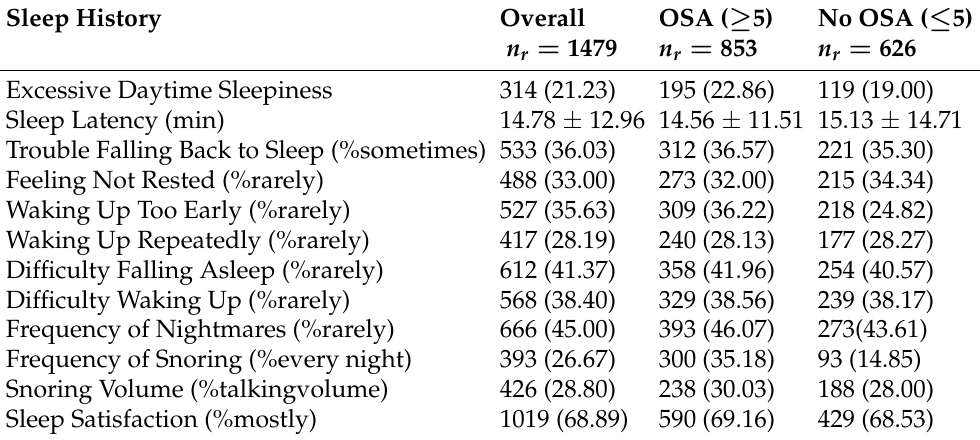
Table A7. Self-reported sleep characteristics of cohort expressed as mean ± standard deviation.